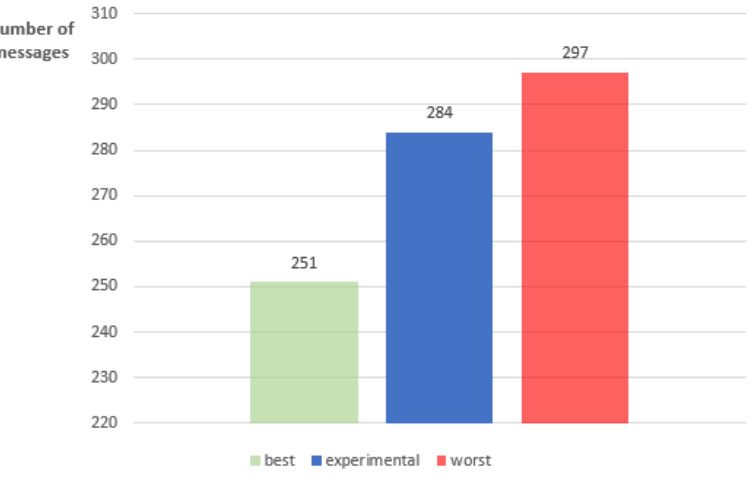
Figure 16. Number of messages exchanged during a